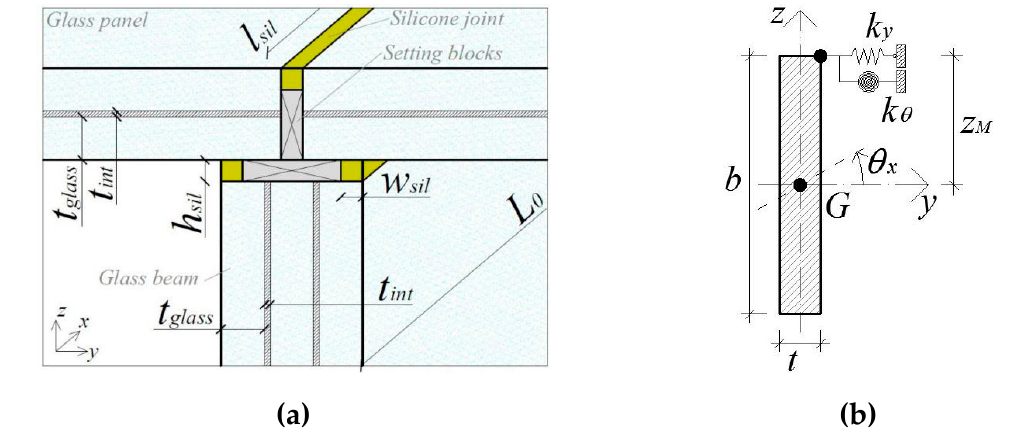
Figure 5. LR glass beams with continuous flexible lateral restraints: ( a ) example of a beam-to-plate adhesive joint, in accordance with [27], and ( b ) reference cross-section. Figures reproduced from [27]